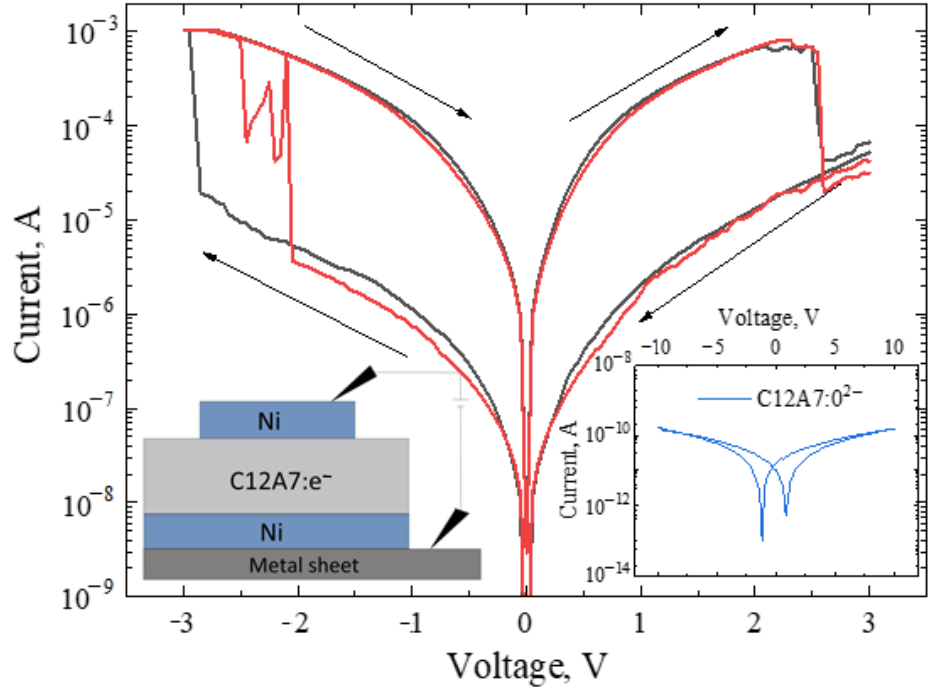
Figure 7. I–V curve of electride C12A7:e − and mayenite C12A7:O 2 − (inset) at room temperature.